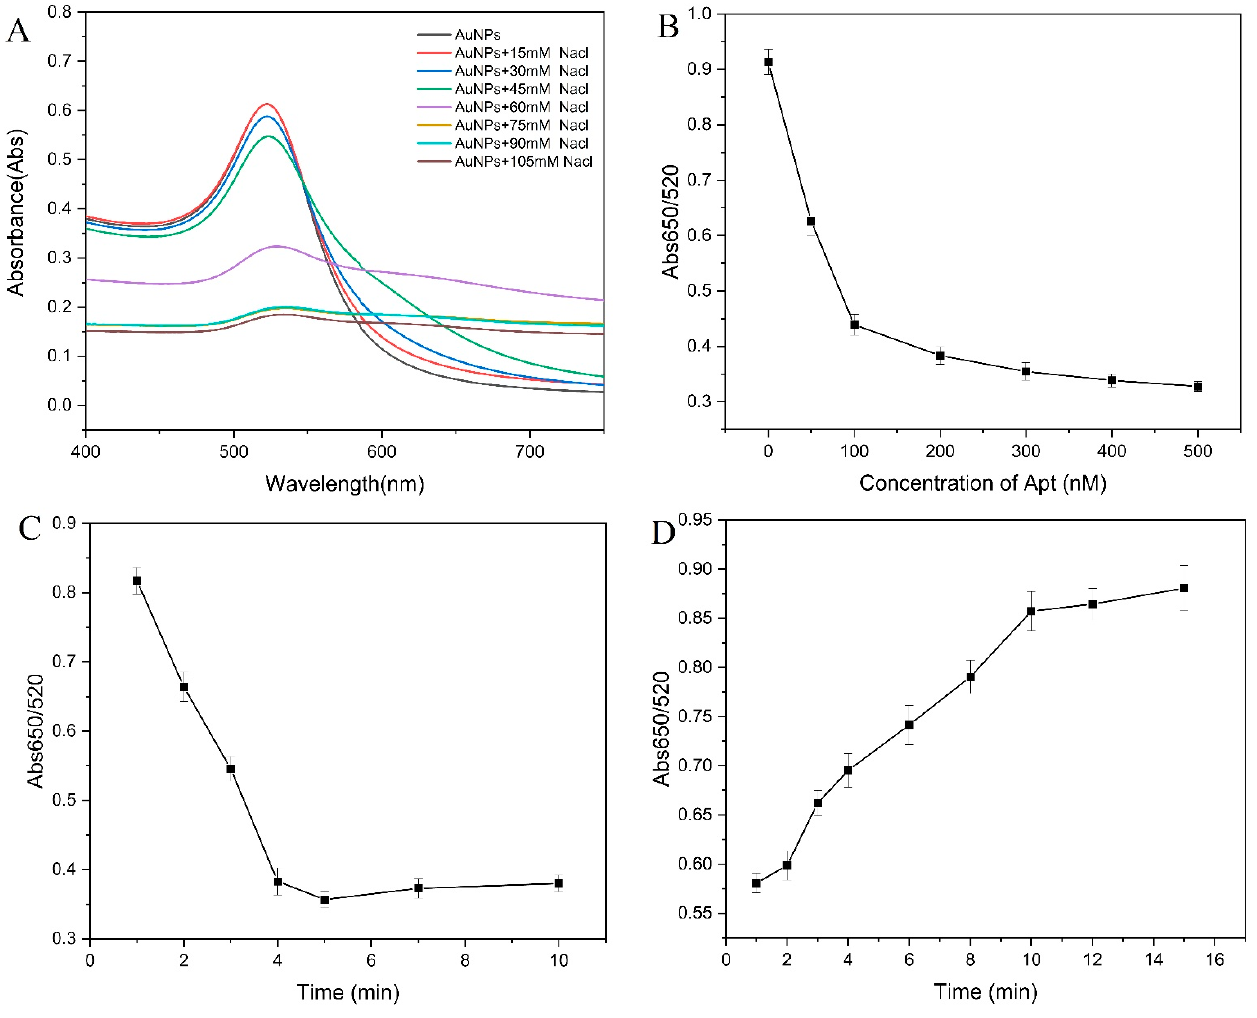
Figure 5. Optimization of the aptamer-AuNPs colorimetric conditions. ( A ) NaCl concentration. ( B ) Aptamer concentration. ( C ) Reaction time between AuNPs and NaCl. ( D ) Incubation time of aptamer and AuNPs.